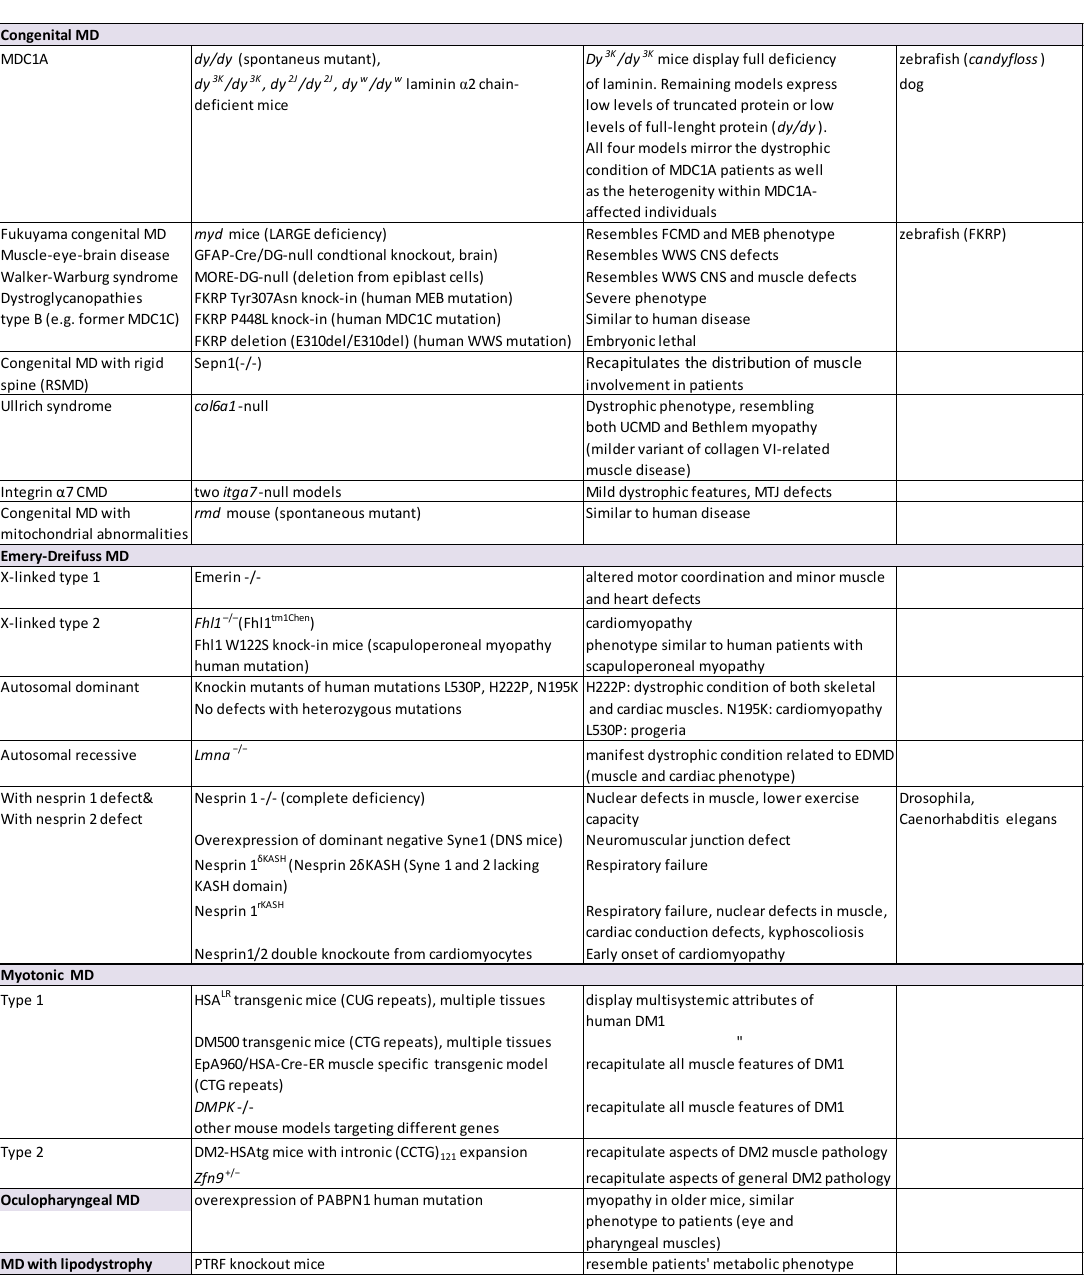
Int. J. Mol. Sci. 2018 , 19 , x FOR PEER